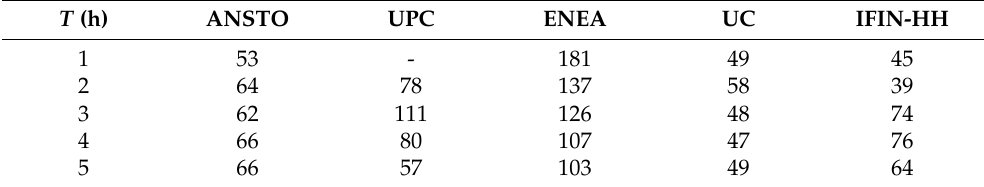
Table 7. Radon flux E (Bq m − 2 h − 1 ) obtained from the linear fit applied over a static accumulation experiment considering some time period T for each